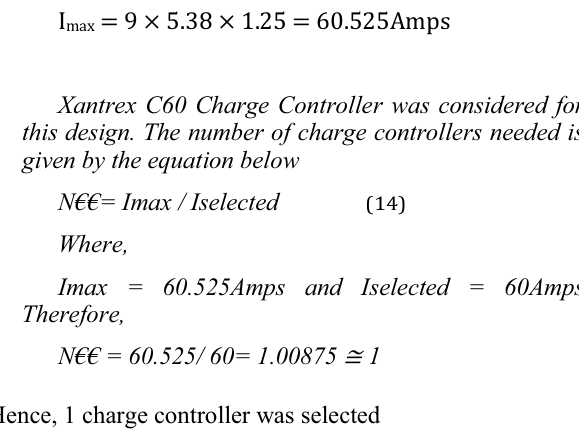
Table 2 : PV-Stand Alone System design by Scanned Excel